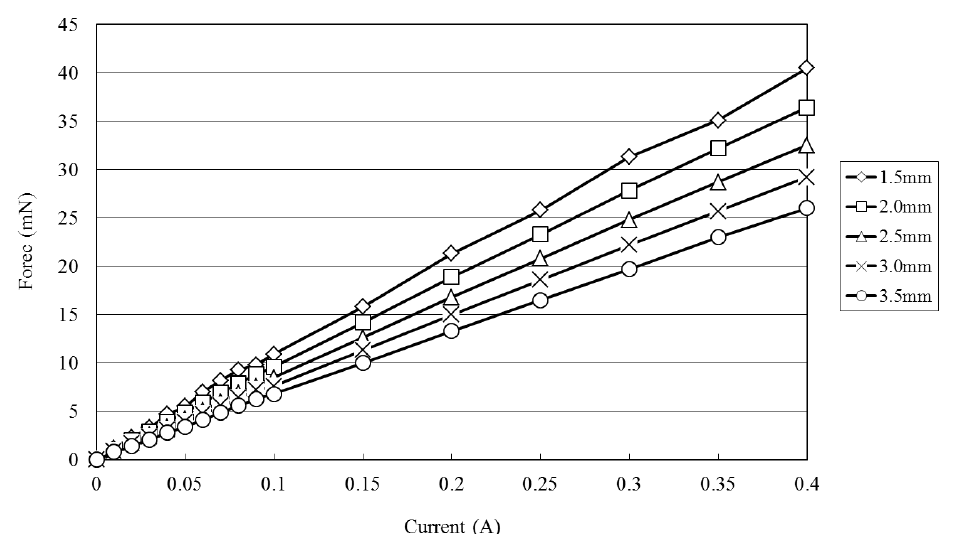
Figure 7. Variation of electromagnetic force with input current (0~0.4 A) at various vertical distances from microcoil surface (Note that results correspond to single-layer microcoil stack)